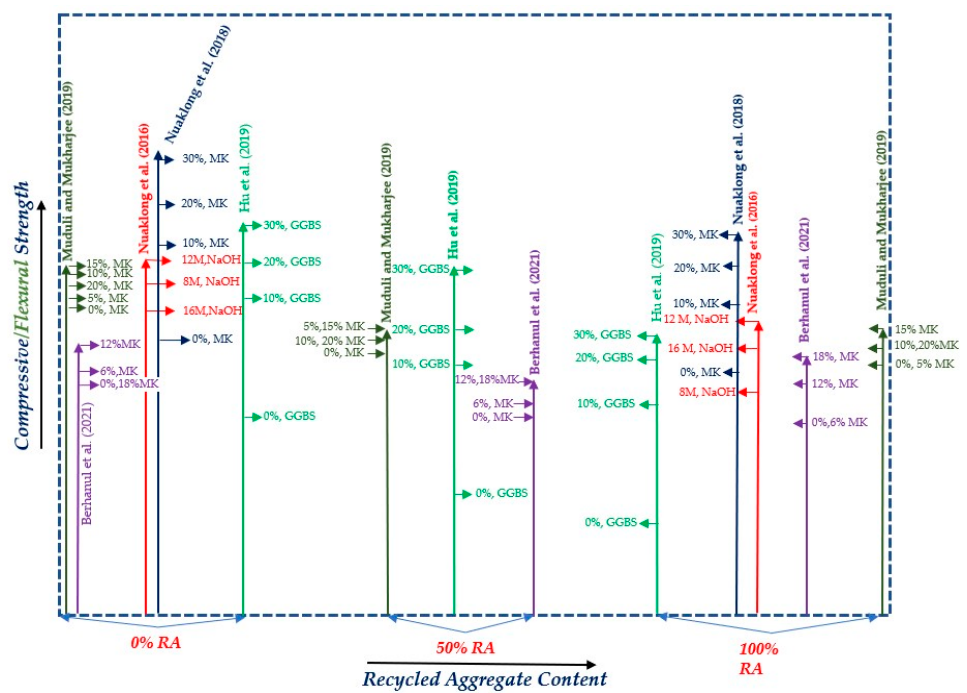
Figure 5. Comparative overview of previous research on GRAC strength with the inclusion of different percentages of RA and other materials (MK and GGBS) [29,33,37,38,40].